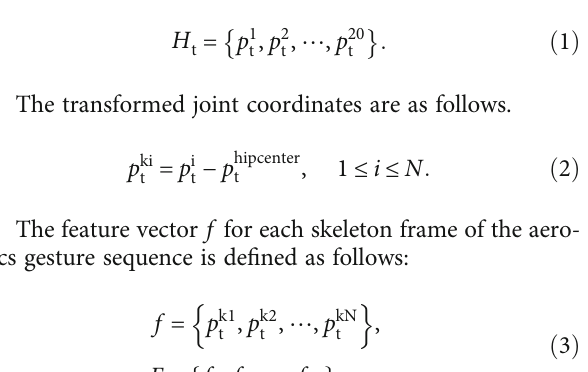
Figure 1: Flowchart of aerobics movement recognition